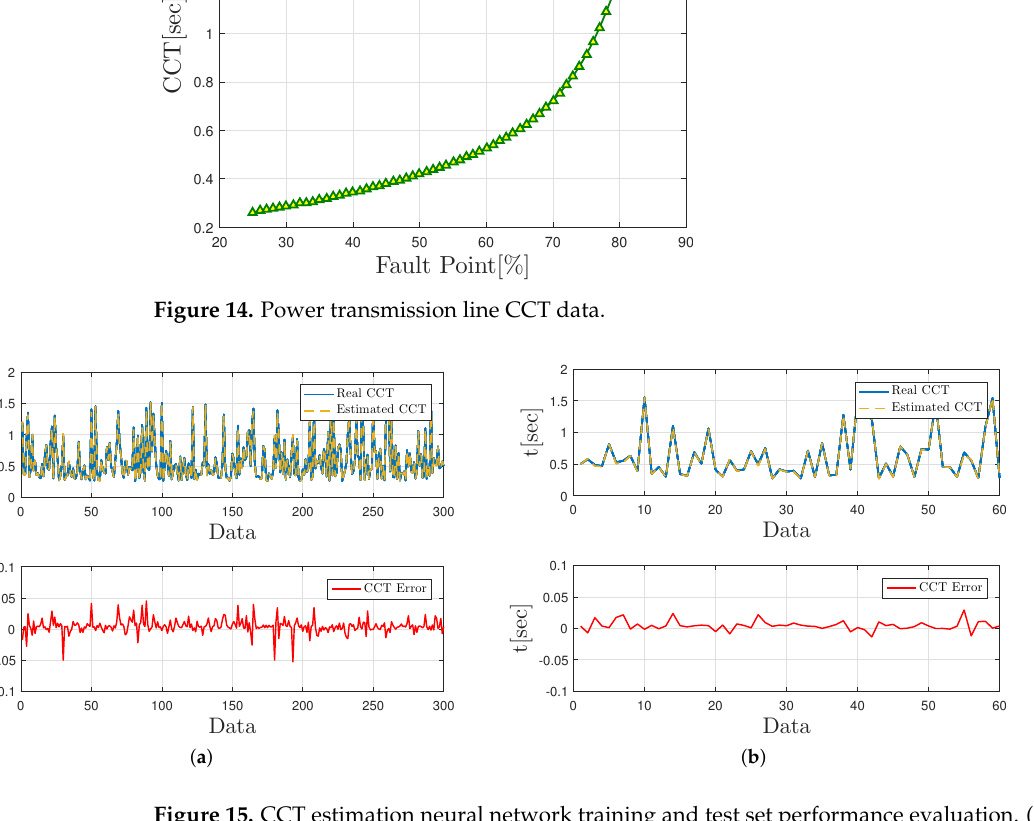
Figure 15. CCT estimation neural network training and test set performance evaluation. ( a ) training dataset error; ( b ) test dataset